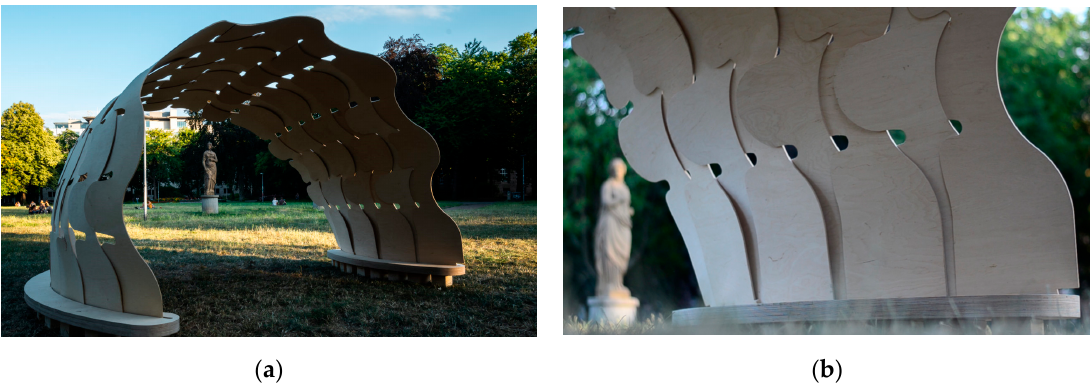
Figure 4. ( a ) The erected Biomimetic Pavilion at the campus of the University of Stuttgart; ( b ) Single pieces with tooth-shaped edges creating a stable interlocking system. © A. Coban and V. Ivanova; BioMat/ITKE-University of Stuttgart